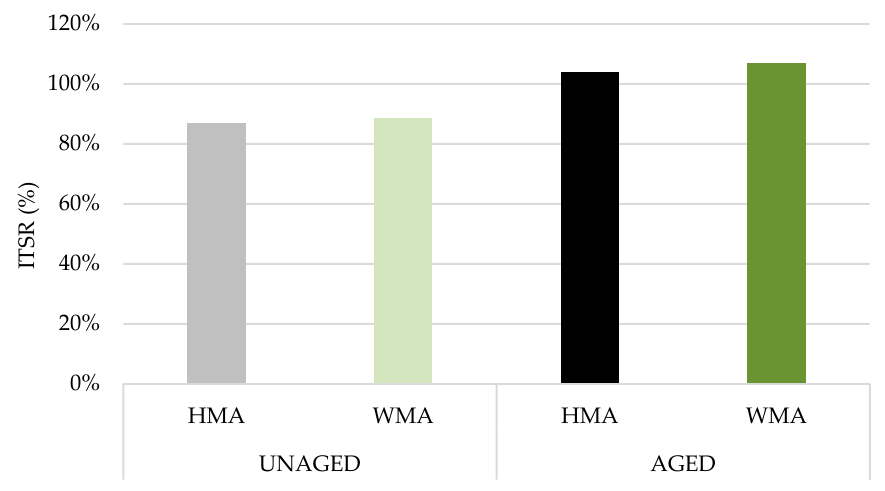
Figure 6. Results of indirect tensile strength.